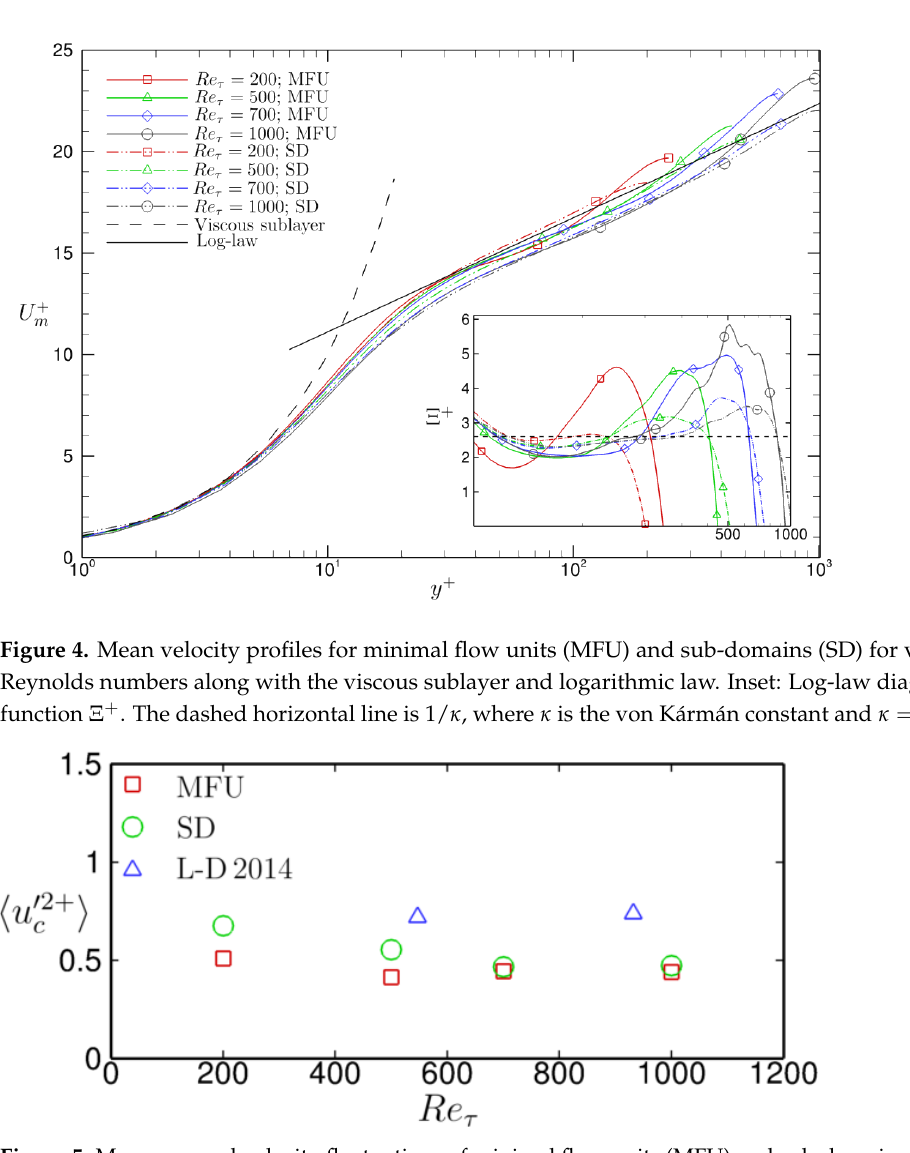
Figure 5. Mean-squared velocity fluctuations of minimal flow units (MFU) and sub-domains (SD) at the channel center for various Reynolds numbers. (cid:52) are values obtained from Lozano-Durán and Jiménez [11] for larger domain simulations (L-D